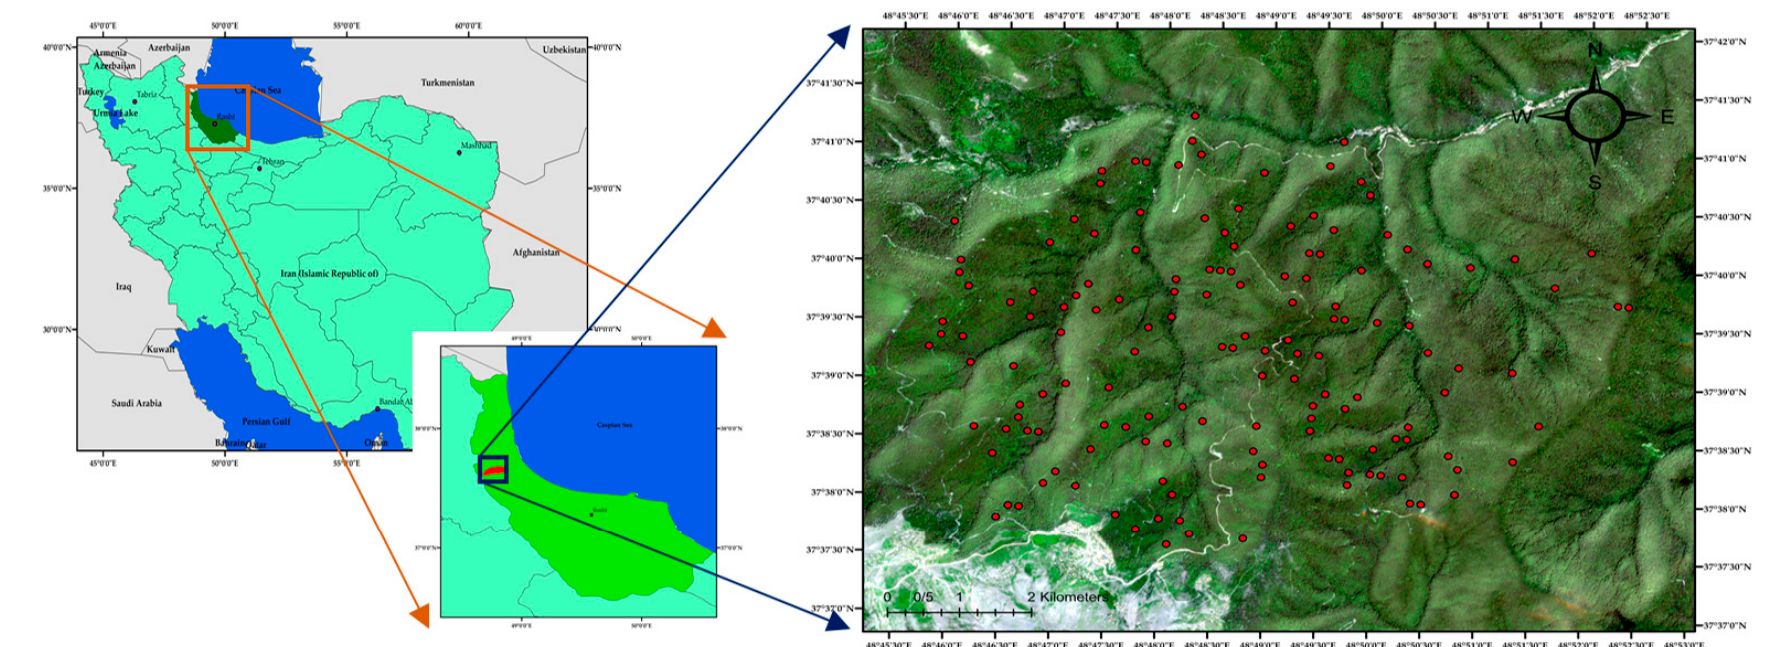
Figure 1. The geographical location of the study area in the WGS 84 coordinate system. The red-points display the field plots locations. Background image is Sentinel-2 RGB image (Red: Band 4; Green: band 3; Blue: band